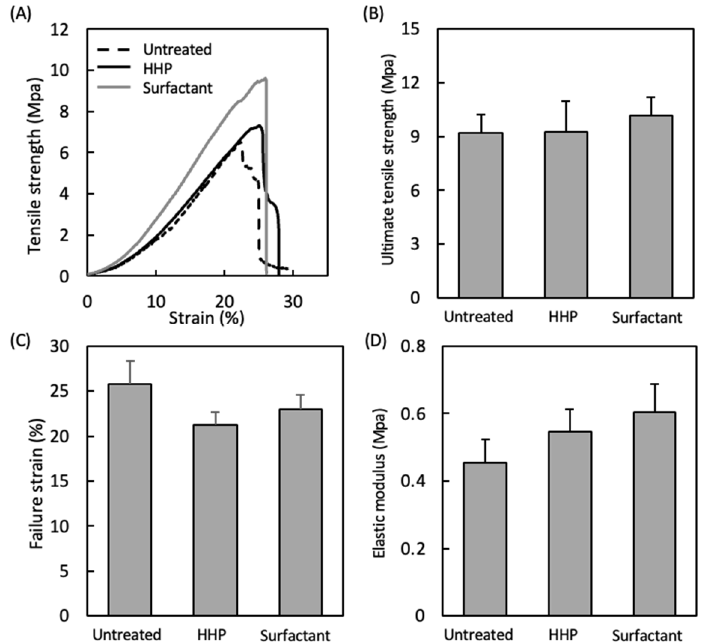
Figure 4. ( A ) Typical stress–strain curves of the untreated pericardium, HHP-decellularized peri- cardium, and surfactant-decellularized pericardium. Mechanical properties of the untreated peri- cardium, HHP-decellularized pericardium, and surfactant-decellularized pericardium: ( B ) ultimate tensile strength, ( C ) failure strain, and ( D ) elastic modulus. Mean ± standard deviation, n = 6; no significant differences were identified between groups (one-way ANOVA, p < 0.05; Tukey’s post hoc